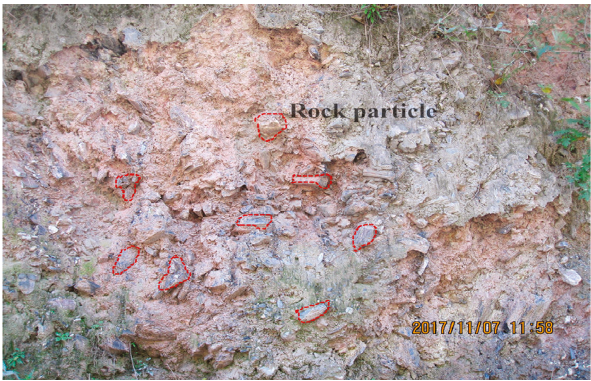
Figure 2: Soil and rock particles mixture of the sampling